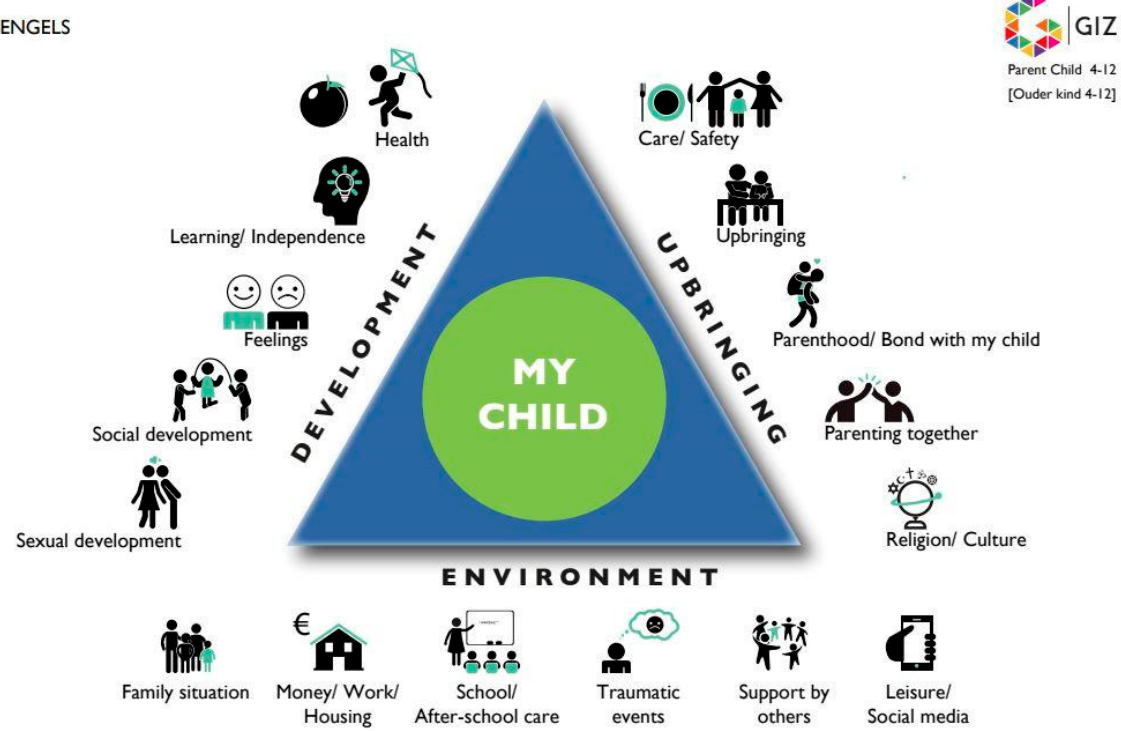
Figure 1. Common Assessment Framework (CAF). Available online: https://ars.els-cdn.com/content/image/1-s2.0-S0190740920321472-gr1a_lrg.jpg (accessed on 29 April 2022).